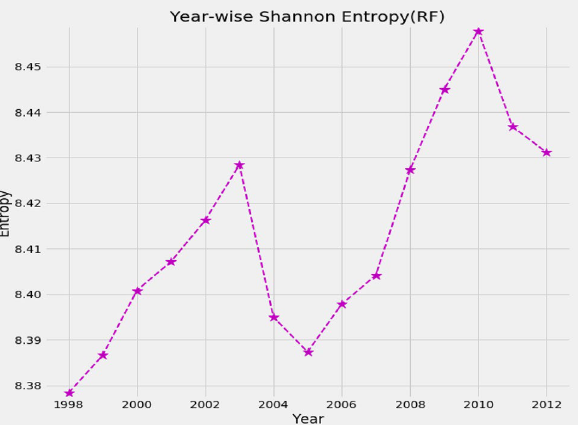
Figure 5. The change of entropy over time. The higher the entropy, the higher the risk of the market.